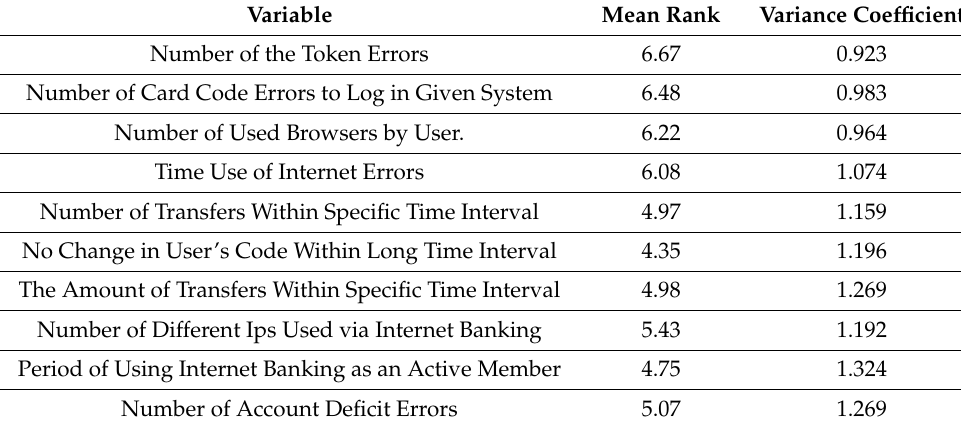
Table 1. Ranking of extracted variables (source: research analysis). Variable Mean Rank Variance Coefficient Number of the Token Errors Number of Card Code Errors to Log in Given System Number of Used Browsers by User.